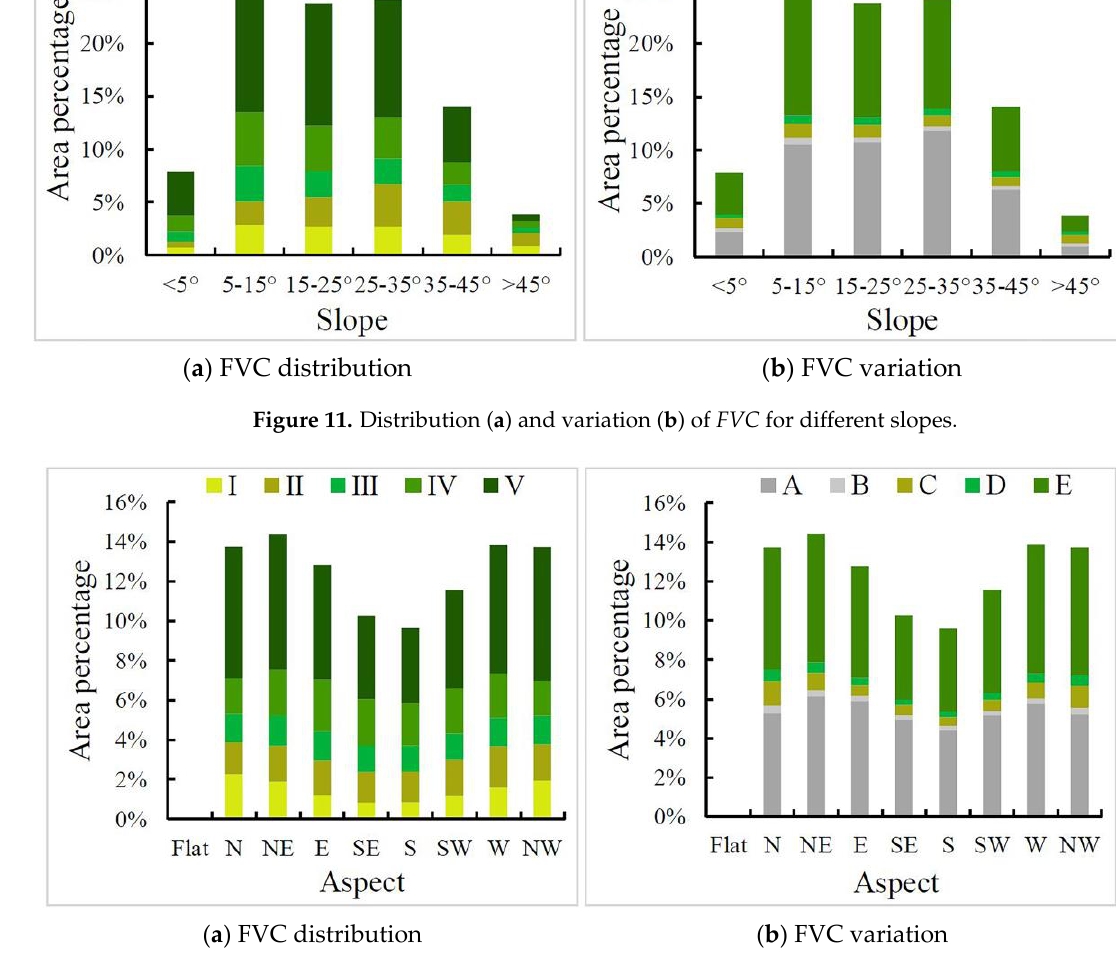
Figure 12. Distribution ( a ) and variation ( b ) of FVC for different slope directions.